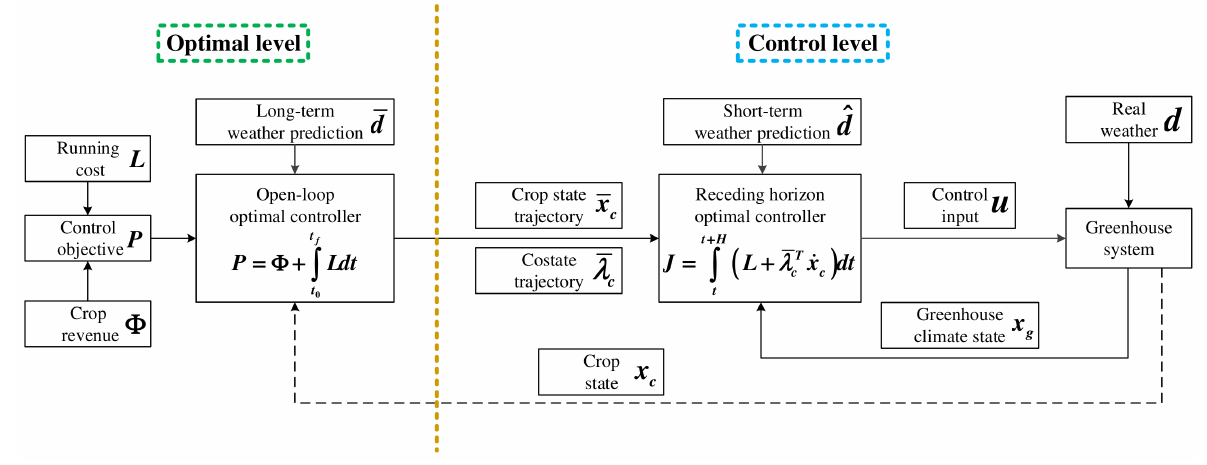
Figure 1. Closed-loop optimal control of greenhouse climate based on two-time-scale